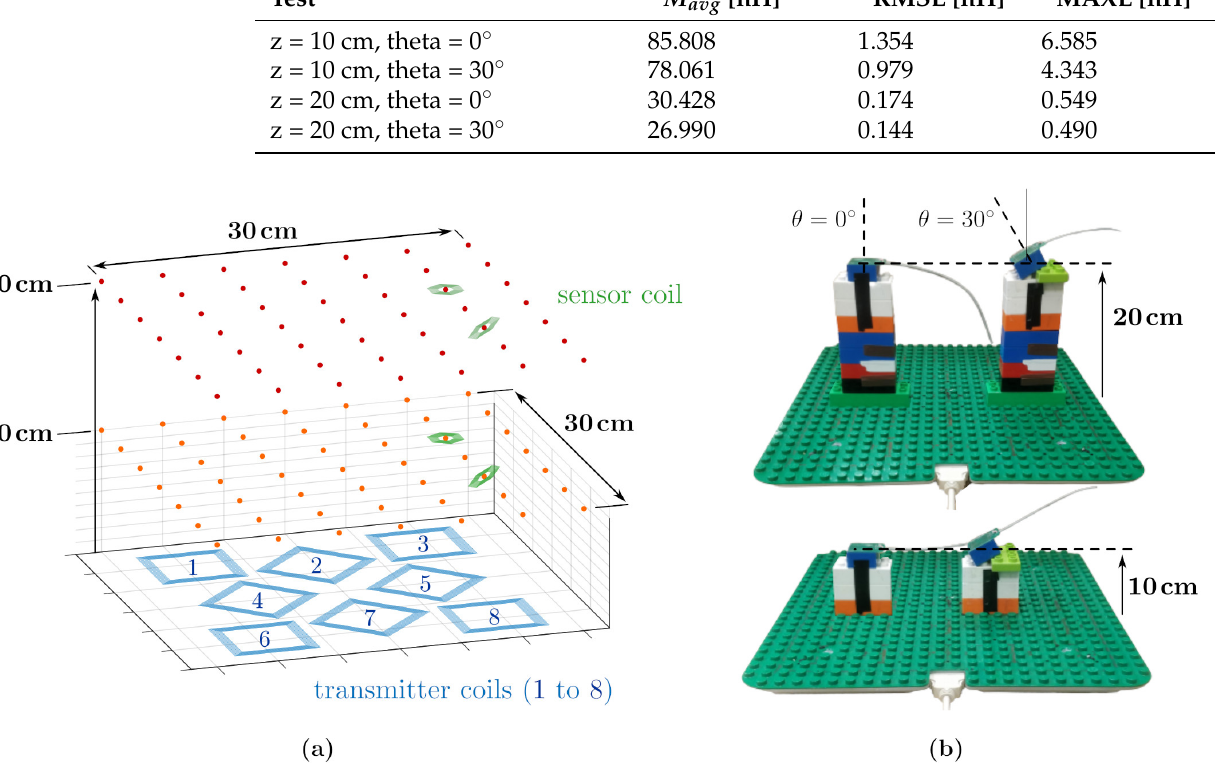
Figure 10. ( a,b ) The mutual inductance was measured on a grid of 7 × 7 points at 10cm and 20cm from the planar field generator, for two sensor orientations: pitch angle θ = 0 ◦ and θ = 30 ◦ . At every test point, the eight mutual inductances between the sensor coil and the eight transmitter coils are considered, leading to a total of 49 × 4 × 8 = 1568 mutual inductances experimentally evaluated.